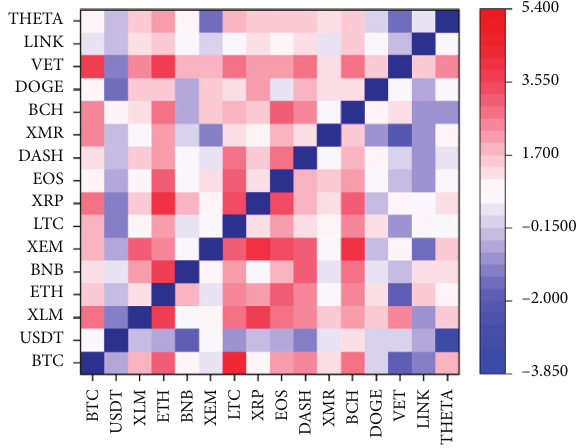
Figure 11: USDT to the other.